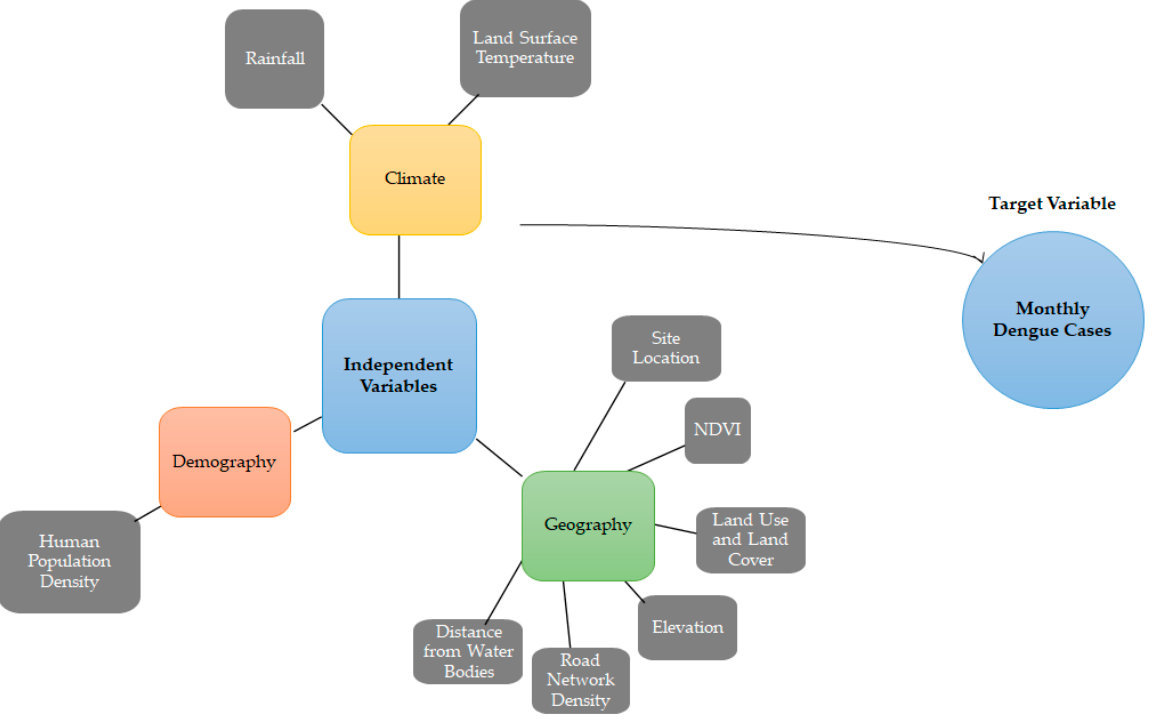
Figure 3. An illustration of the variables used in the dengue prediction models.